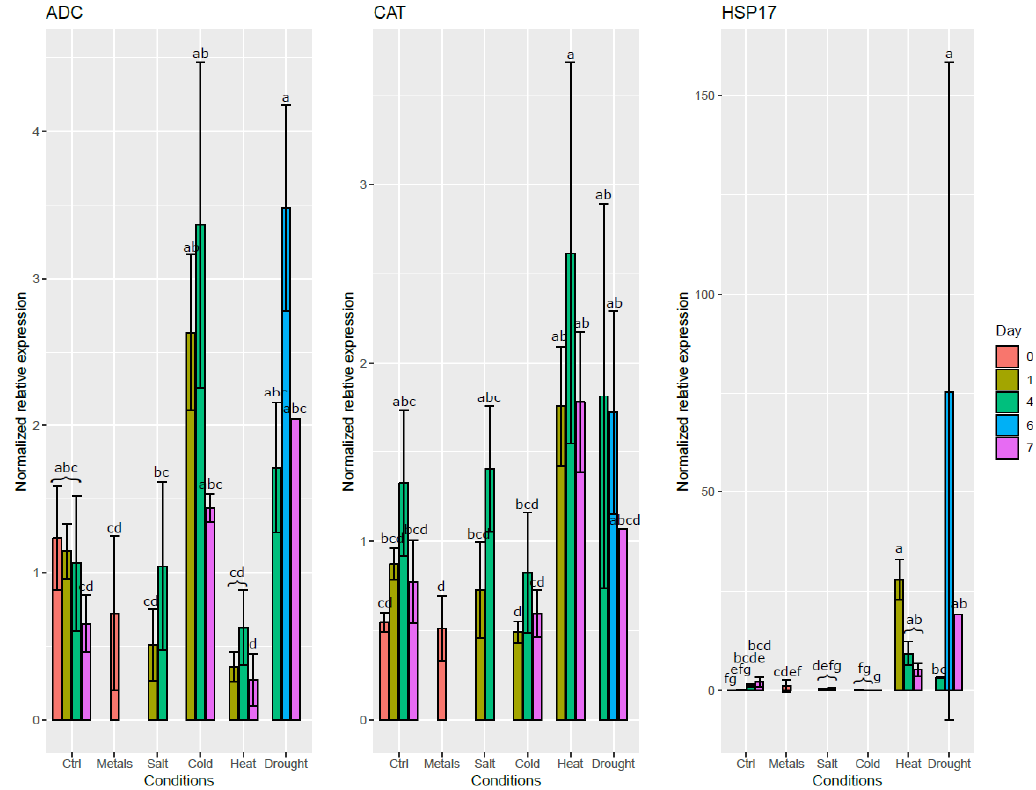
Figure 4. Normalized relative expression level of three stress-responsive genes in the roots of S. viminalis exposed to various abiotic stresses for up to two months. Data was normalized using ACT , ARI8 , CDC2 , EF1b and TIP41 . Means that share a letter are not significantly different at α = 0.05.